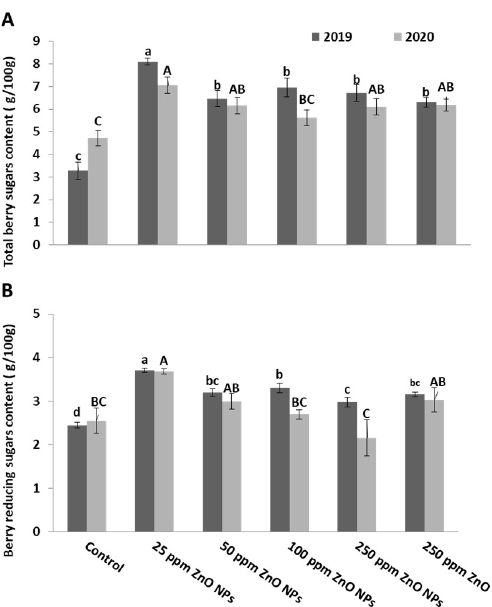
Figure 5. Effect of ZnO NPs foliar spraying on leaf enzymatic activity, ( A ) PAL and ( B ) SOD, of grapevine Crimson seedless cultivar during two seasons: 2019 and 2020. Different letters indicate the differences based on Duncan’s multiple range test.